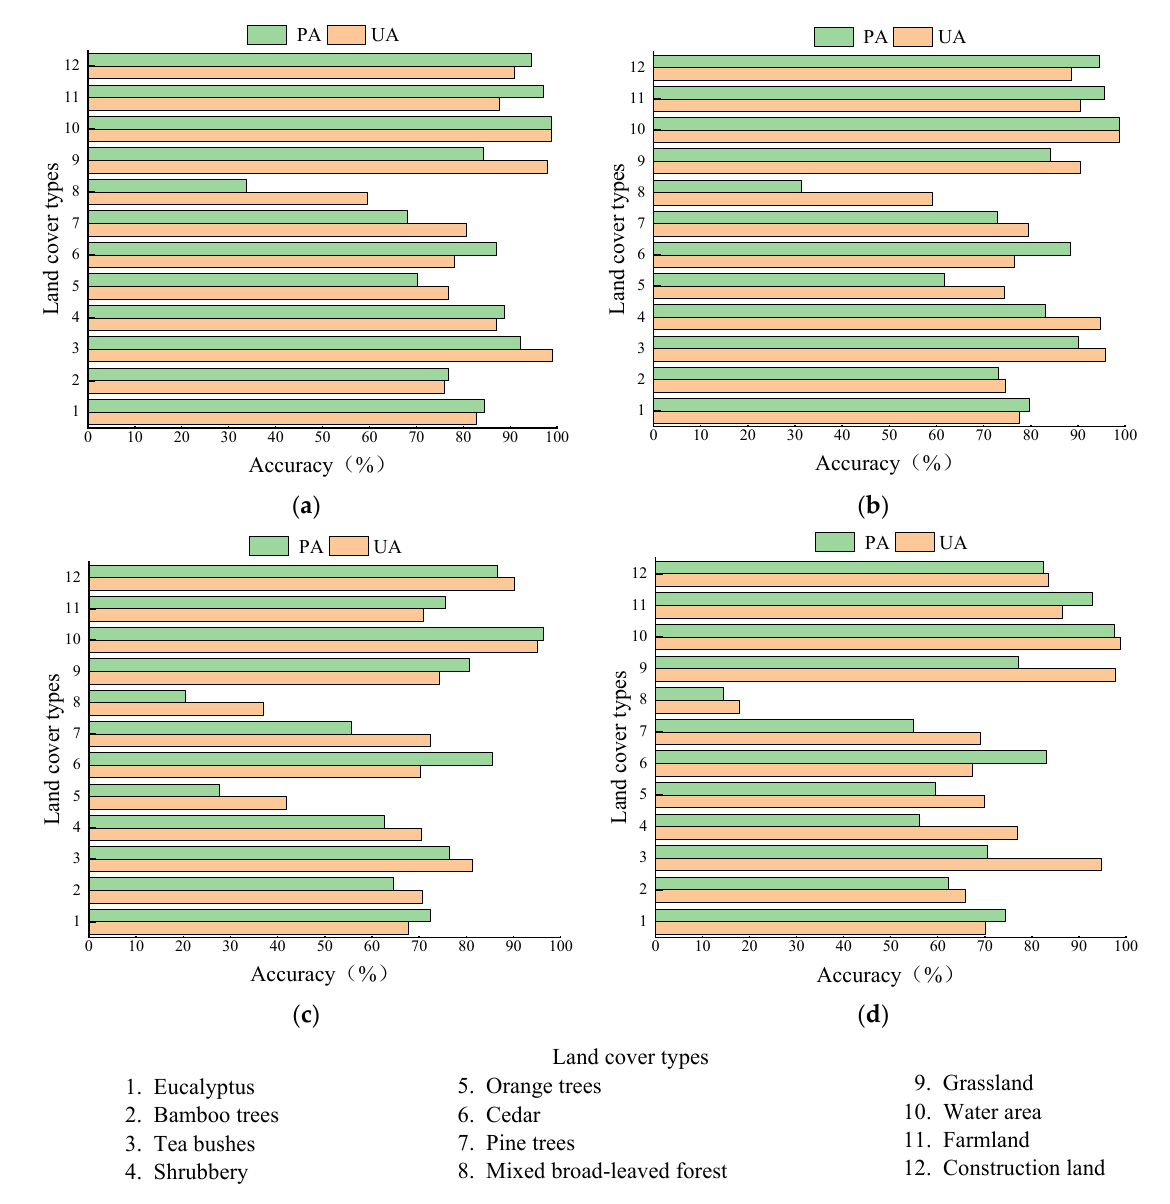
Figure 7. PAs and UAs of the different classification methods: ( a ) RF; ( b ) GTB; ( c ) SVM; ( d ) CART. The producer and user accuracies of the forest tree species classification models con- structed with four different classification algorithms based on the optimal feature varia- bles were statistically plotted (Figure 7). The user and producer accuracies of the tea bushes classification results were the highest of all four classification algorithms. The ac- curacy of tea bushes classification with the RF algorithm was the highest. The user accu- racy was 98%, 3.12%, 17.70%, and 4.22% higher than that of the GTB, SVM, and CART algorithms, respectively. The producer accuracy was 92%, 1.96%, 15.68%, and 21.57% higher than that of the GTB, SVM, and CART, respectively. The user and producer accu- racies of the mixed broad-leaved forest results were relatively low and much lower than the results for the other tree species. The RF algorithm had the highest classification accu- racy for mixed broad-leaved forest, but the user accuracy was only 59% and the producer accuracy was only 34%. The main reason for the low classification accuracy for the mixed broad-leaved forest is that it has characteristics of multiple tree species. It is still difficult to accurately distinguish it from other broad-leaved tree species through the combination